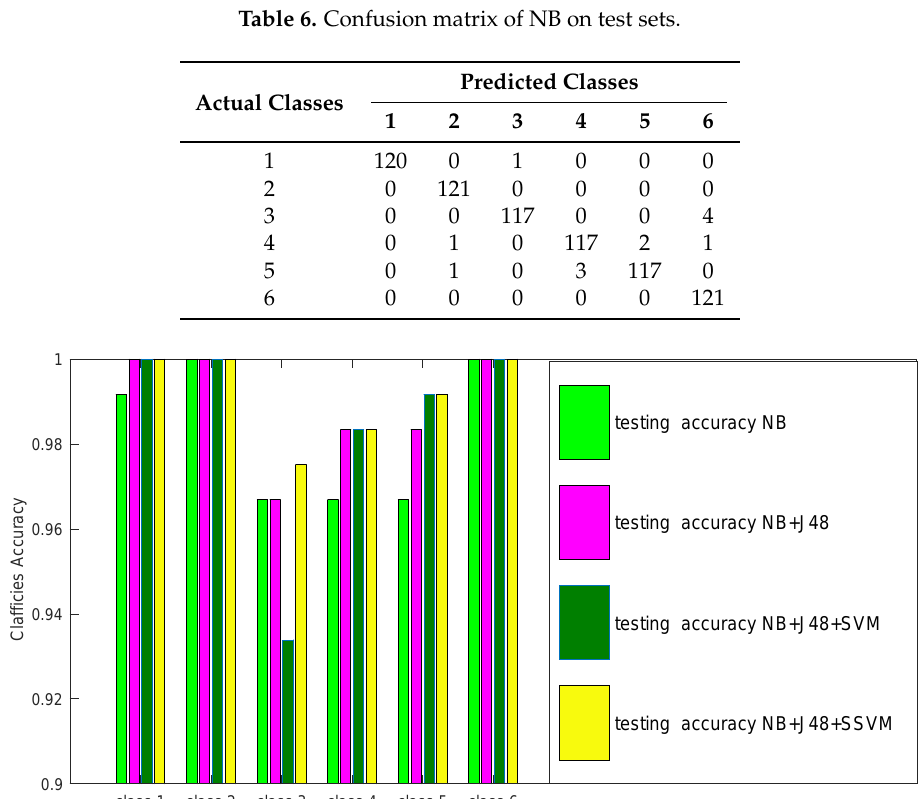
Figure 10. Testing accuracy comparison of each condition in the